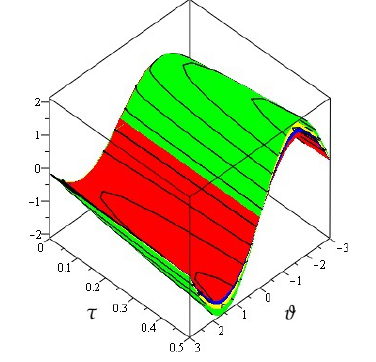
Figure 12. The different fractional-order of (cid:36) of ν ( ϑ , ζ , z , τ ) of Example